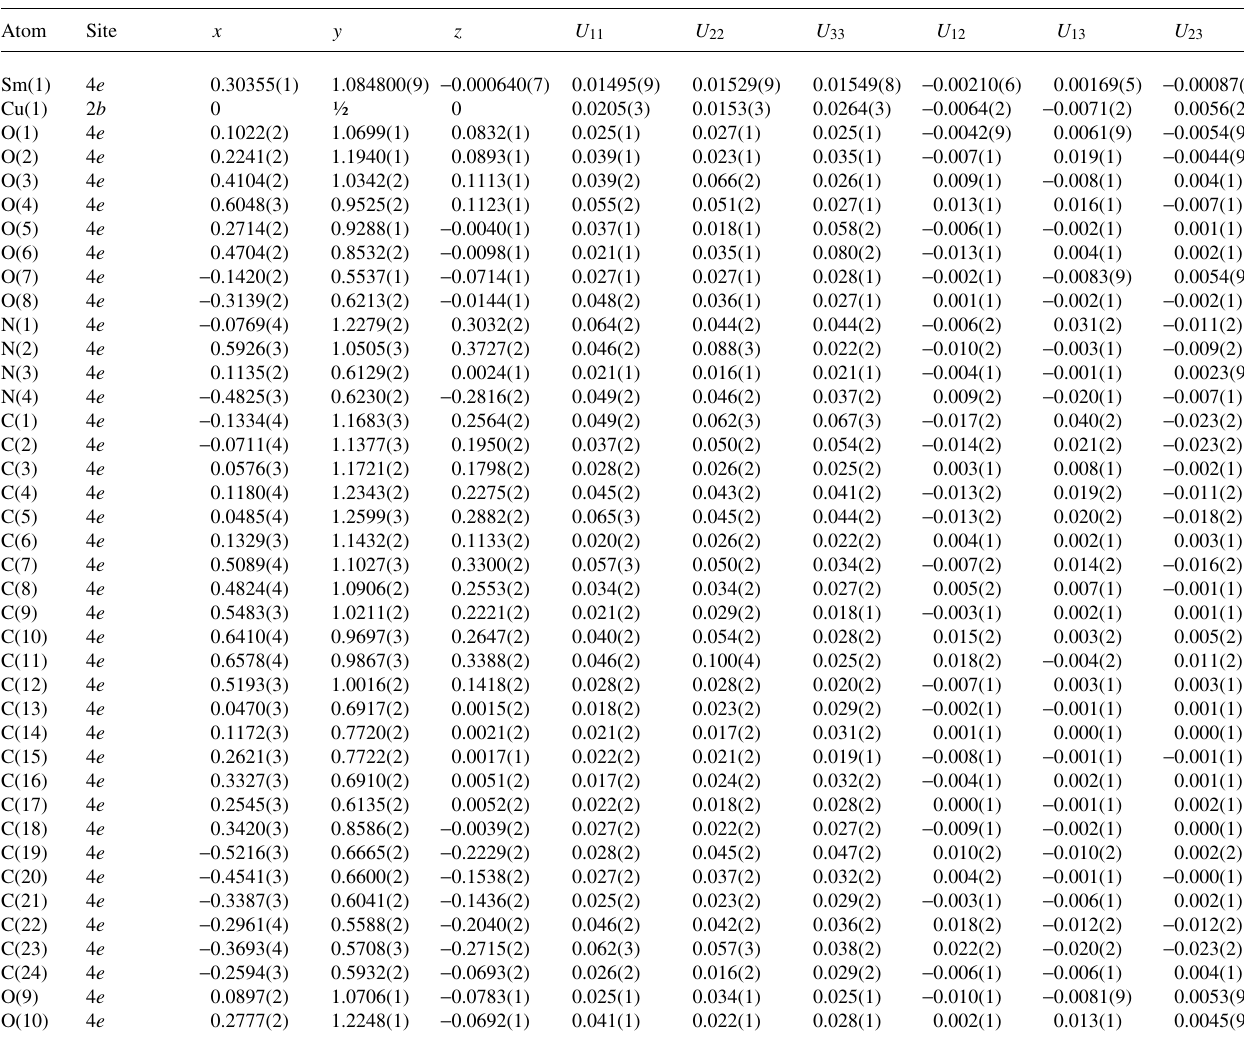
Table 3. Atomic coordinates and displacement parameters (in Å 2 ) .